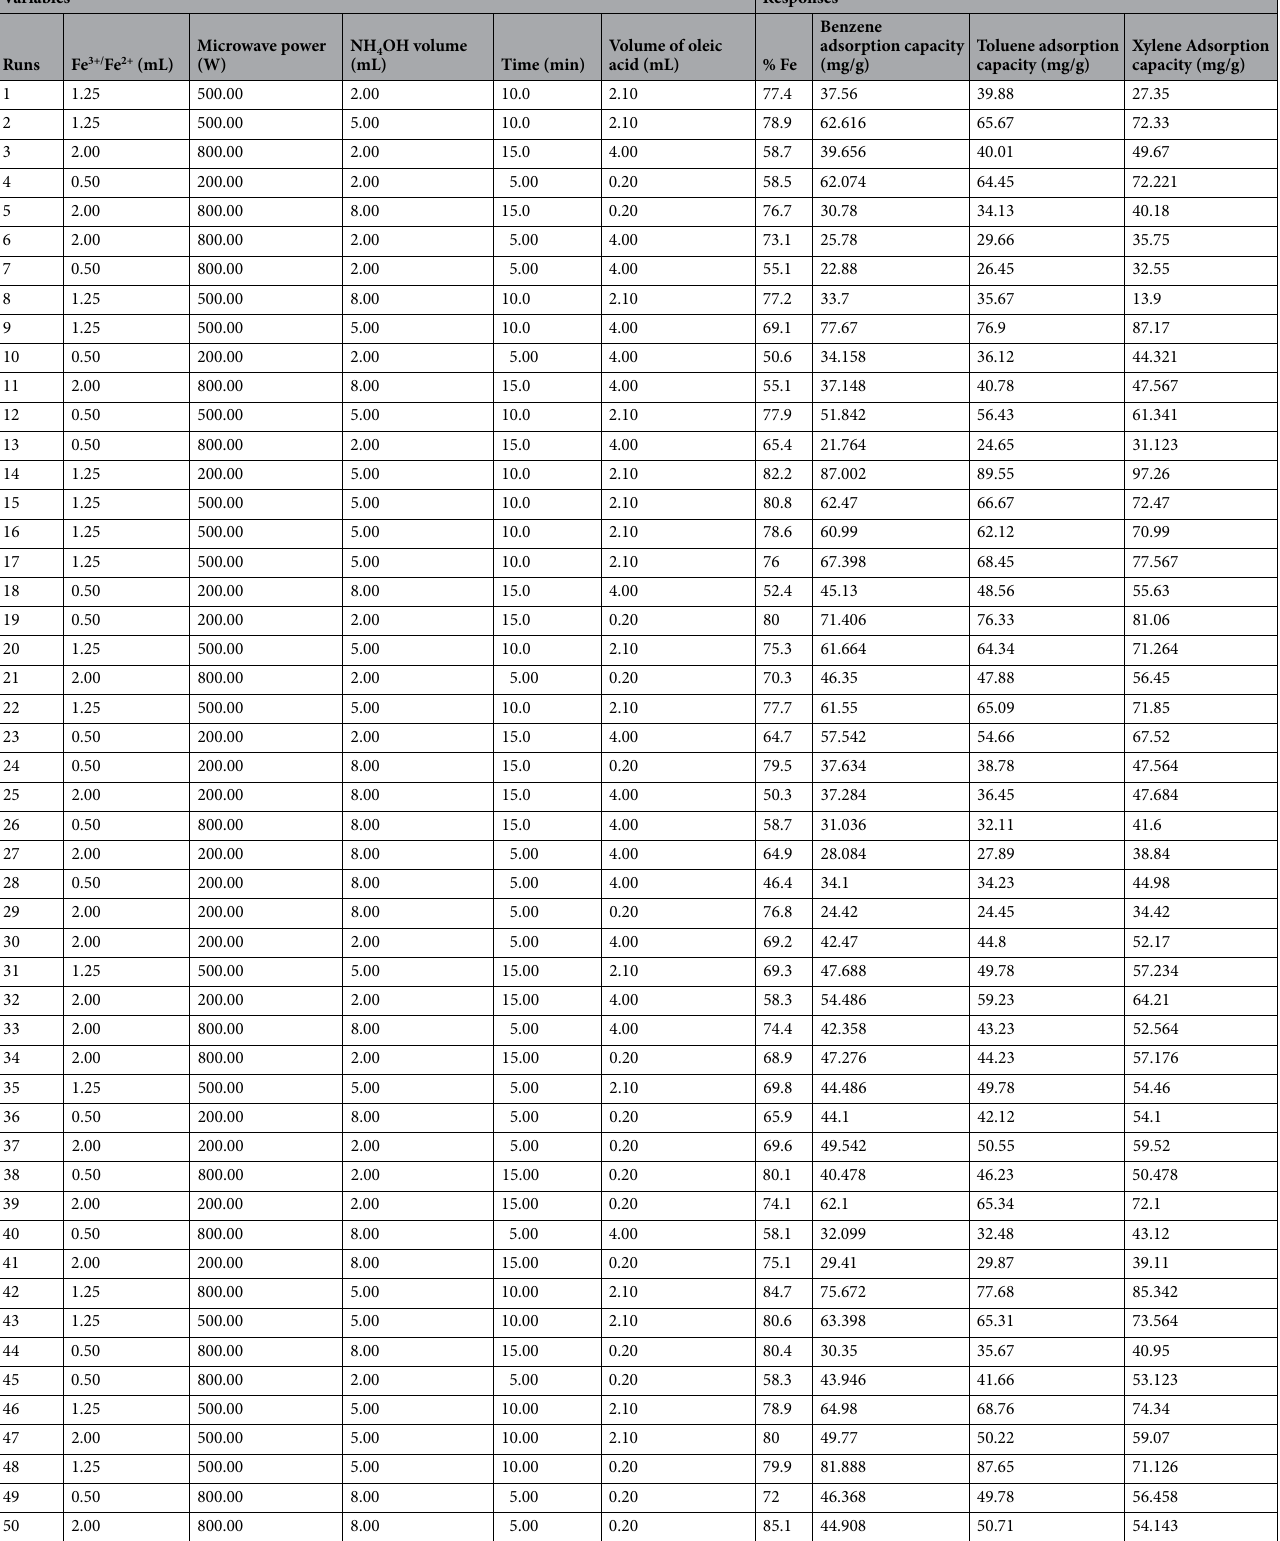
Table 2. Experimental design and results for preparation of Oleic Acid Coated Magnetite with % Fe content and adsorption capacities for